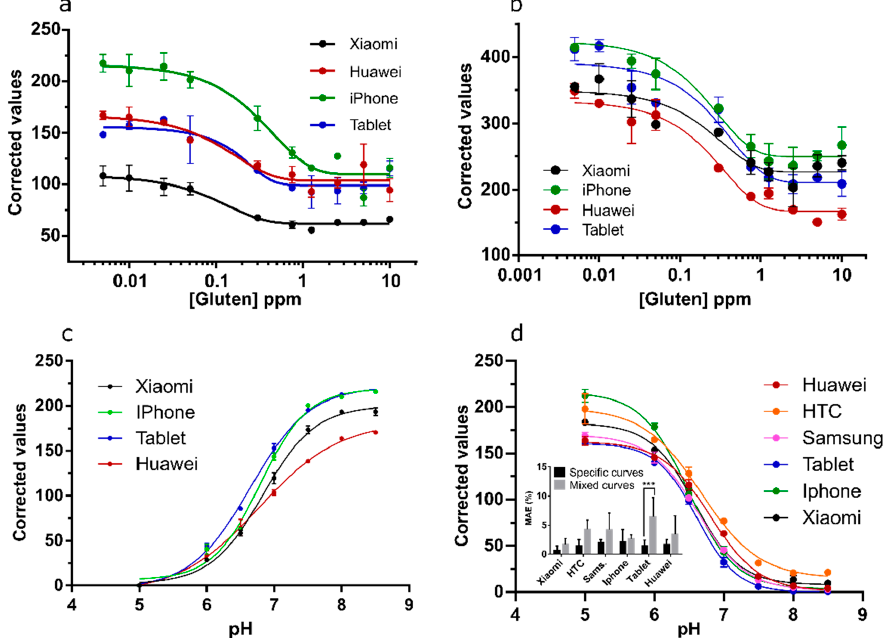
Figure 12. ( a ) B channel values fitted to four calibration curves for LFA quantification of gluten spiked into buffer with four phones (models indicated). ( b ) Calibration curves for LFA quantification using corrected ∆ RGB values. ( d ) R channel values fitted to calibration curves for pH estimation of bu ff ered soil extracts with six phones (models indicated). Inset, the results of post-hoc analyses on the MAEs for pH predictions (n = 15) using the phone’s specific calibration curve or a mixed curve of all phone